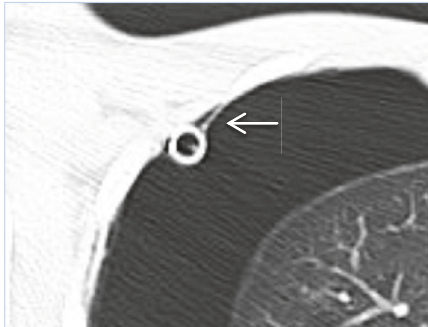
Figure 4: Chest CT axial cut magnified showing the location of the chest tube in relation to the chest wall and parietal pleura. White arrow: parietal pleural.